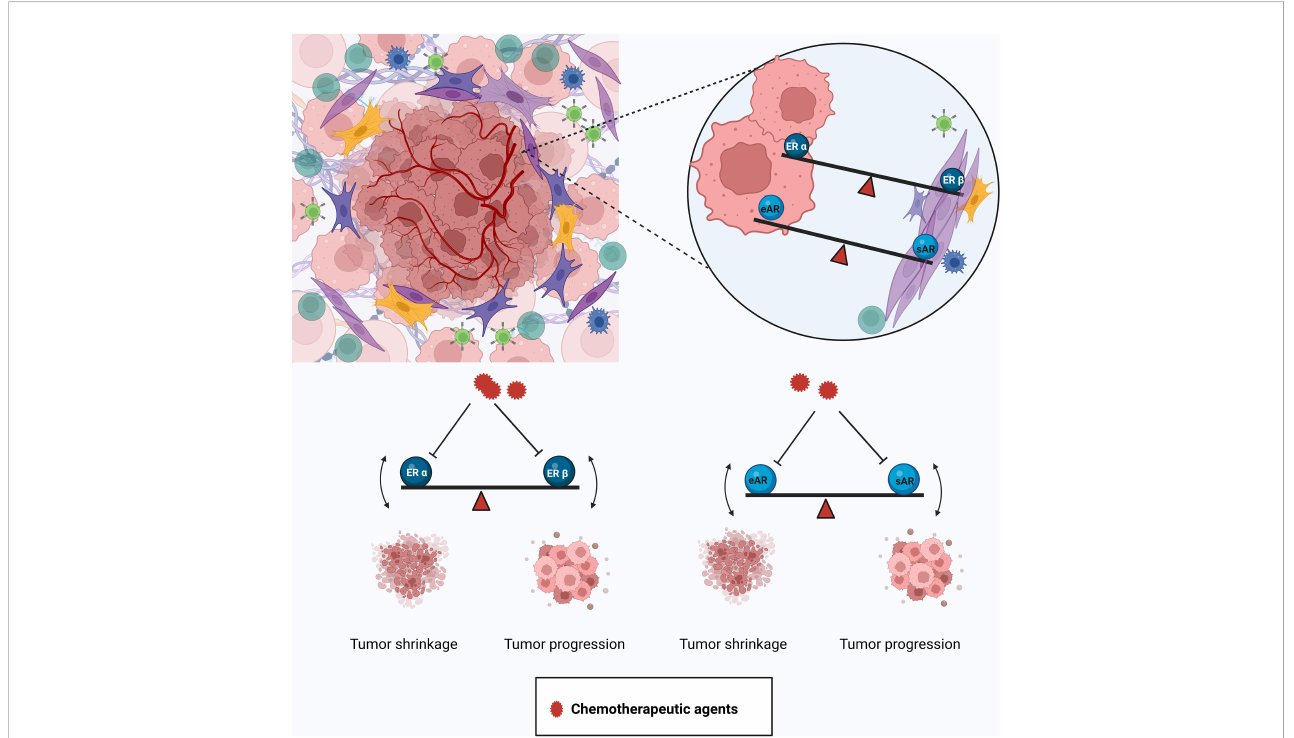
FIGURE 2 Differential distribution and effects of the AR and ER in the tumor and tumor microenvironment. The tumor is harbored in a complex microenvironment composed of different kinds of cells like immune cells, cancer-associated fi broblasts (CAFs), etc. The AR and ER show differential distribution and effects in the tumor and the stroma. Inhibiting the actions of the ER- a in the epithelium by certain drugs (e.g., tamoxifen) also suppresses the tumor-suppressive property of the ER- b in the stroma and disturbs the balance leading to resistant disease. Similarly, agents used to inhibit the tumor-promoting function of the epithelial AR (eAR) cause the stromal AR (sAR) to lose its tumor-suppressive action. Created in